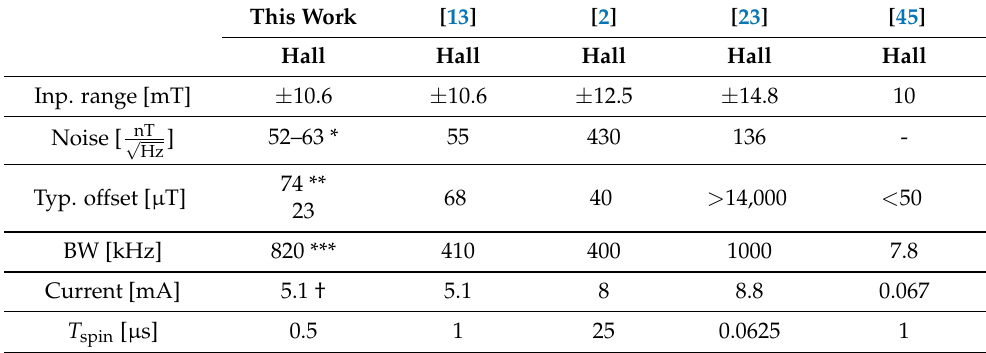
Figure 18. Fitted cumulative Gaussian distribution over 10 samples of the input-referred Hall plate residual offset with traditional four-phase spinning (black) and randomized four-phase spinning (red) for f spin 666kHz, 1MHz and 2MHz. Table 2. Comparison